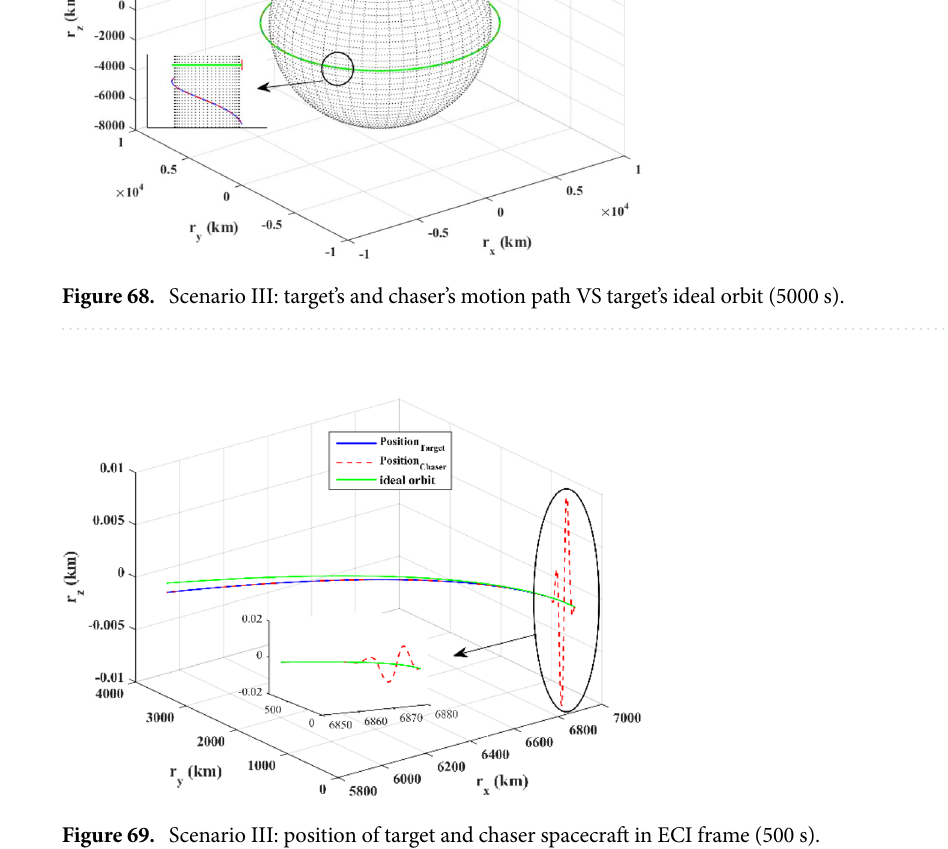
Figure 69. Scenario III: position of target and chaser spacecraft in ECI frame (500